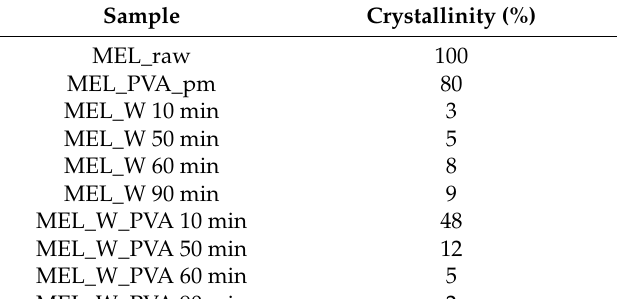
Figure 1. XRPD examination of MEL_raw and MEL_PVA_pm.